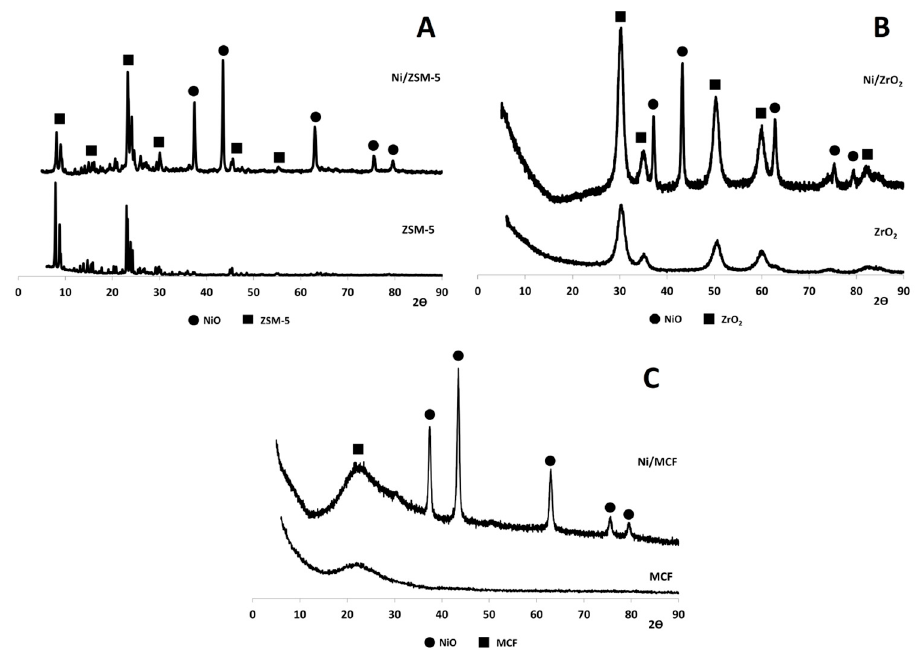
Figure 2. X-ray di ff raction (XRD) di ff ractograms of: ( A ) ZSM-5 and Ni / ZSM-5, ( B ) ZrO 2 and Ni / ZrO 2 , Figure 2. X-ray diffraction (XRD) diffractograms of: ( A ) ZSM-5 and Ni/ZSM-5, ( B ) ZrO 2 and Ni/ZrO 2 , and ( C ) MCF and Ni / and ( C ) MCF and Ni/MCF.